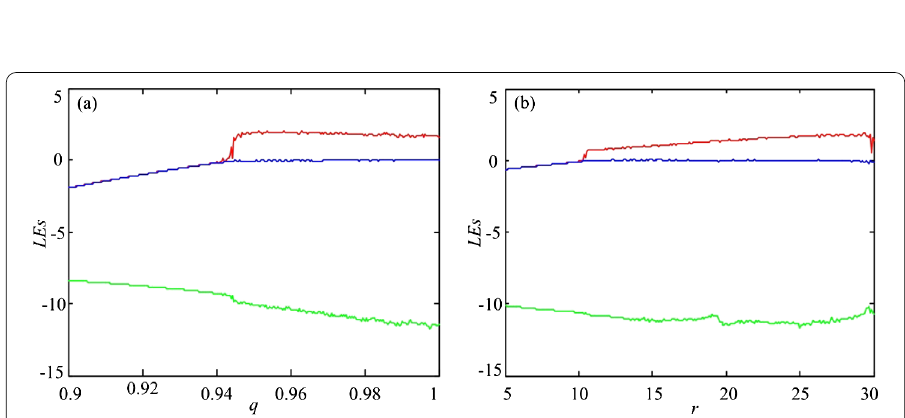
Figure 2 LEs of the fractional-order financial risk system ( a ) LEs with q varying; ( b ) LEs with r varying